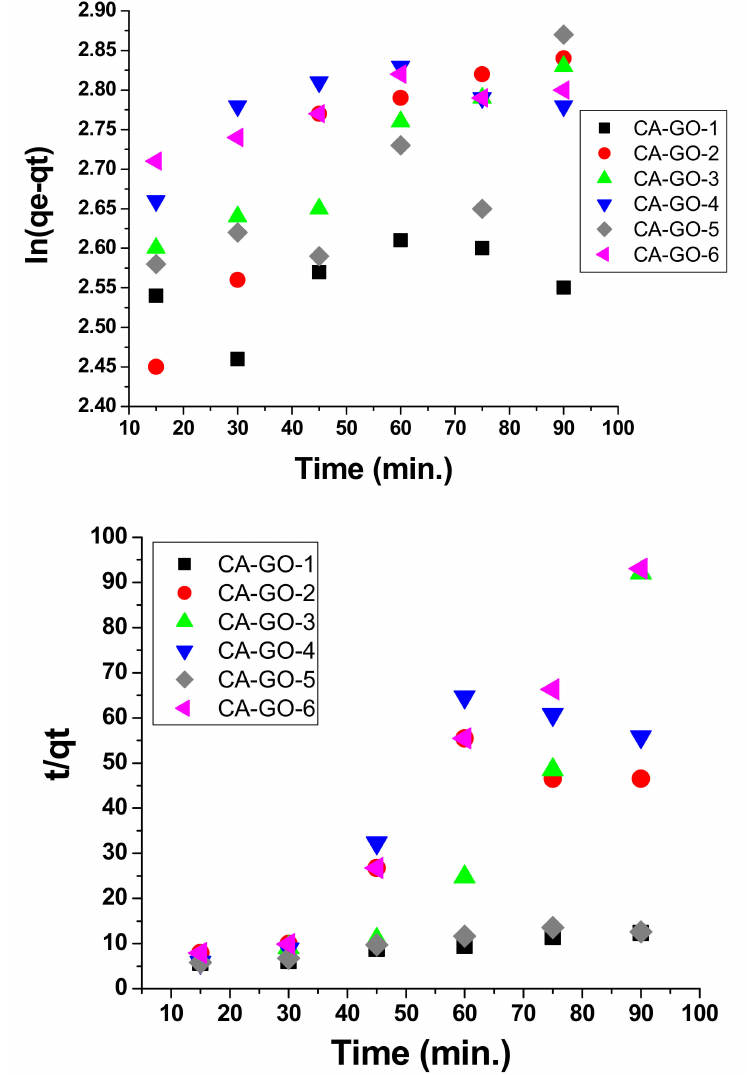
Figure 6. Kinetic models of (top) pseudo first order and (bottom), pseudo second order processes for the adsorption of Ni 2 + by di ff erent CA-GO adsorbents at di ff erent time periods. + Langmuir and Freundlich modeling systems for the adsorption of Ni 2 onto CA-GO adsorbents ◦ were investigated at room temperature (25 C) for 30 min using adsorbent weight at 20 mg and initial concentration of 10 mg / L (Figure 7). Isotherms were mainly best fit to Langmuir modeling, which could be attributed to the high regression coe ffi cient ( R 2 ) value (Tables 2 and 3). Therefore, it can be concluded that the surfaces of all CA-GO adsorbents are homogeneous, and the adsorption occurred